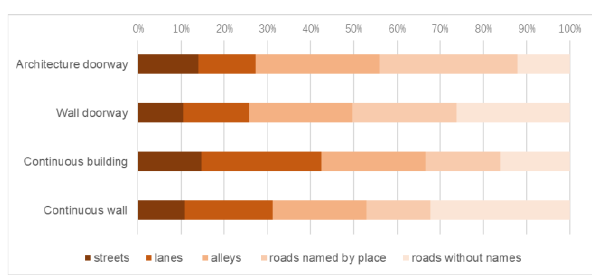
Figure 14. Coupling analysis of the distribution of building forms along the five types of roads